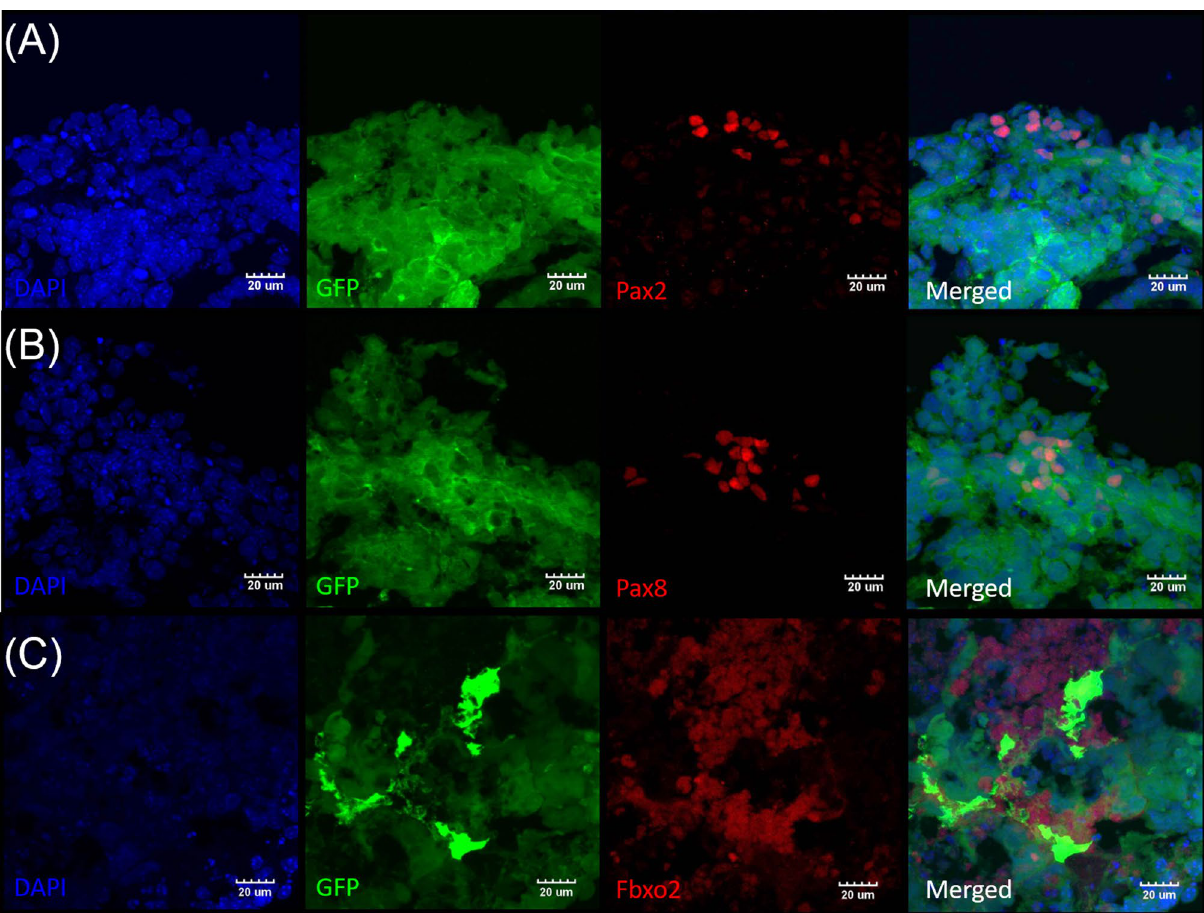
Figure 4. ESC-EBs differentiated into otic progenitor cells via contact co-culture with HEI-OC1 cells. Representative high magnification images of ( A ) Pax2 + , ( B ) Pax8 + and ( C ) Fbxo2 cells in GFP + EBs indicate otic progenitor’s presence. Images are representative of EBs isolated from at least three separate experiments. Scale bars are 20